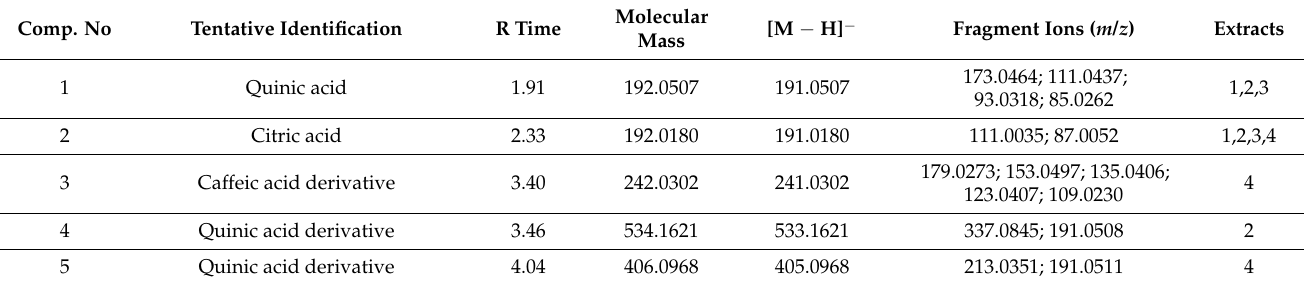
Table 2. Compounds identified in the studied